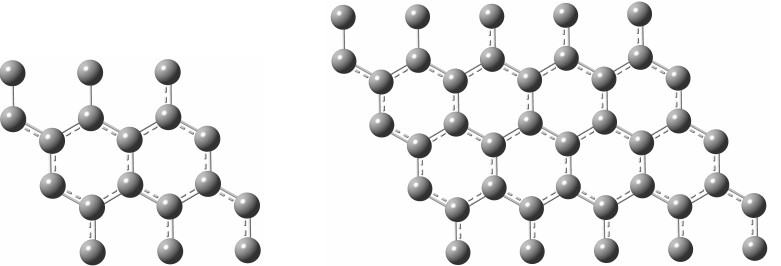
Figure 1. Graphene unit cells used for different acid concentrations ( left , high; right , low). High/low concentration corresponds to one acid molecule in a supercell with 18/32 C atoms for MLG and 36/64 atoms for